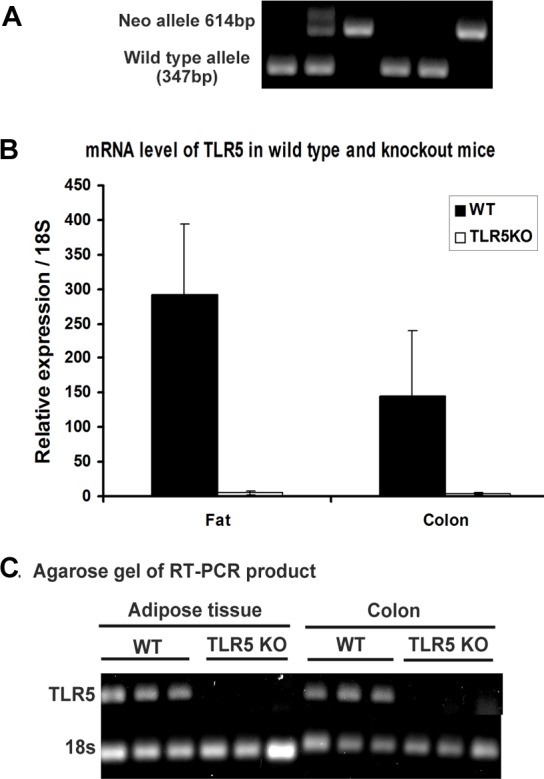
Generation of TLR5 knockout mice.A: genotyping results (WT-wild type, HT-heterozygous, KO-knockout); B: Real-time PCR quantified mRNA levels of TLR5 in wild-type (WT) and knockout mice (TLR5KO), adipose tissue and colon tissue were shown. C: Real-time PCR products were run on 1% agarose gel and confirmed knockout of TLR5.